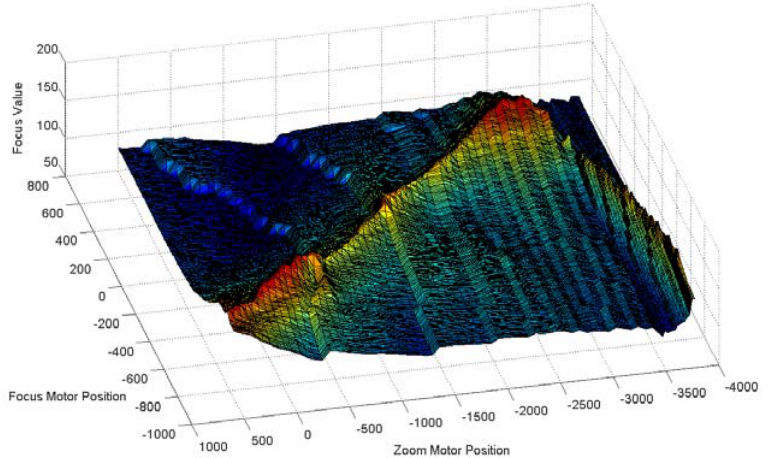
Figure 7. Focus values for each motor position.